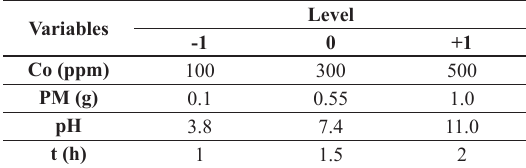
Table 1. Variables of the 2 1-4 experimental design with center